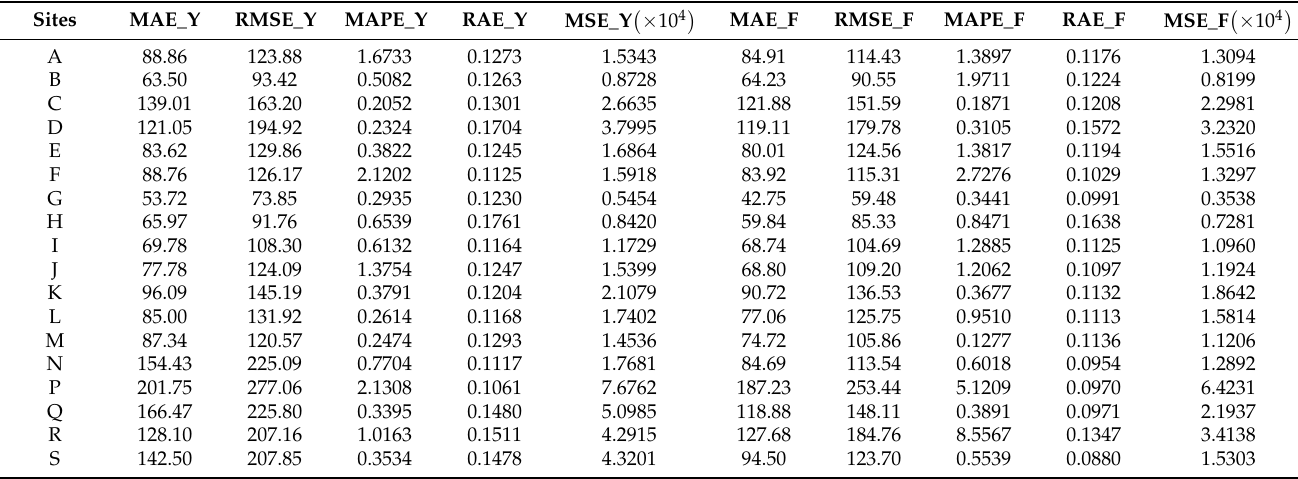
Table 8. Error analysis for the estimated normal distribution (Y) and the estimated fitness curve (F), where the first five columns describe the error in the PDF and the last five columns describe the errors in the fitness curve for the 7 GHz horizontal